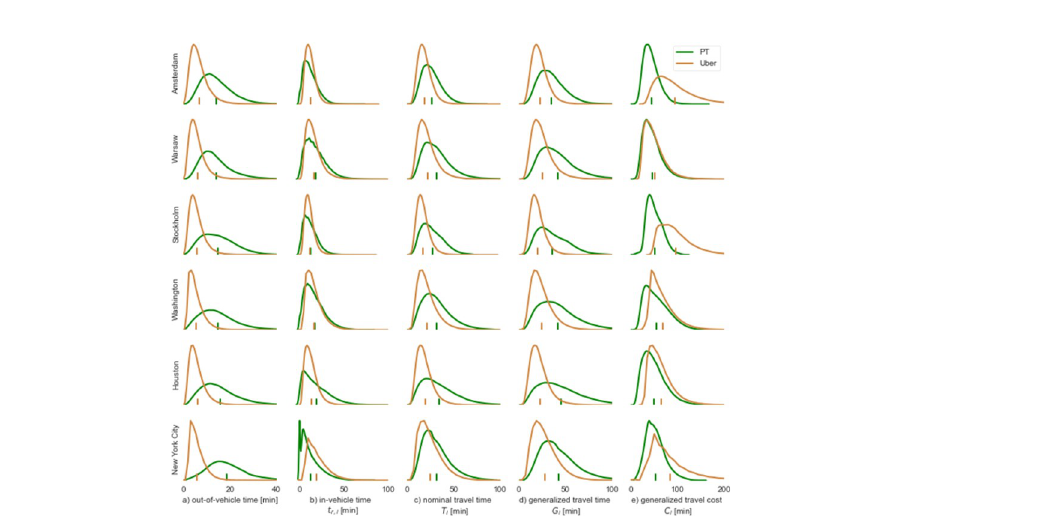
Fig 1. Histogram of out-of-vehicle time (a), in-vehicle time (b), nominal journey time (c), generalized travel time (d) and generalized travel cost (e) by public transport and Uber for each of the six cities. Median values are denoted by the x-axis